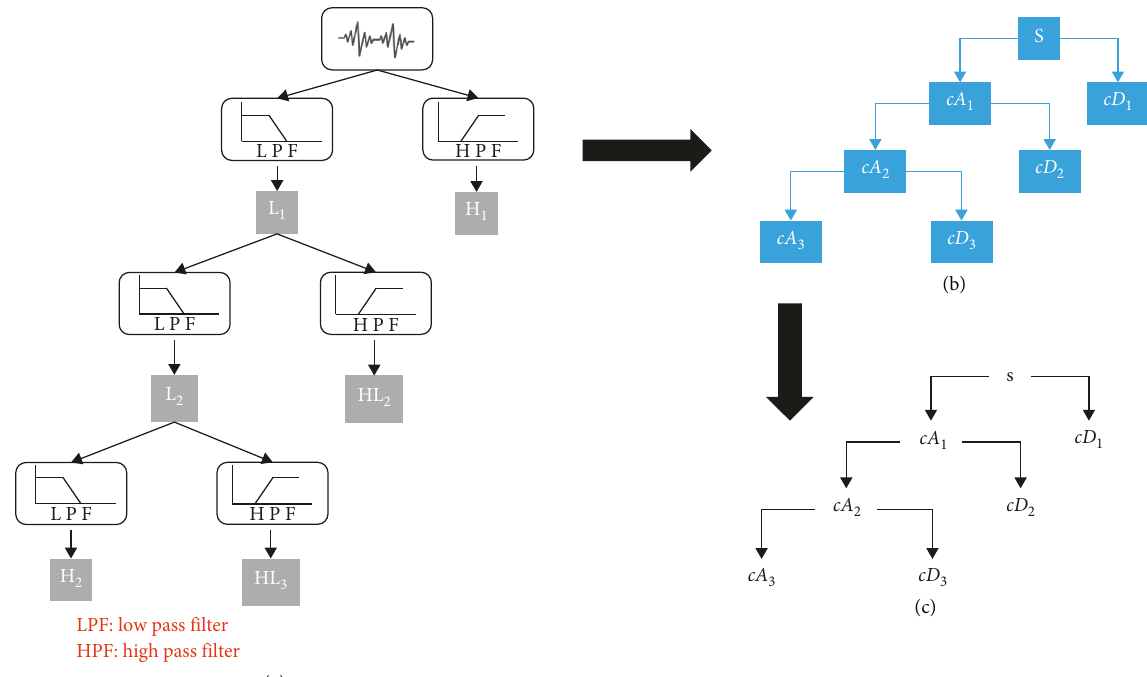
Figure 1: Muscle strength stratification. (a) Single decomposition, (b) Coefficient structure and (c) Wavelet decomposition